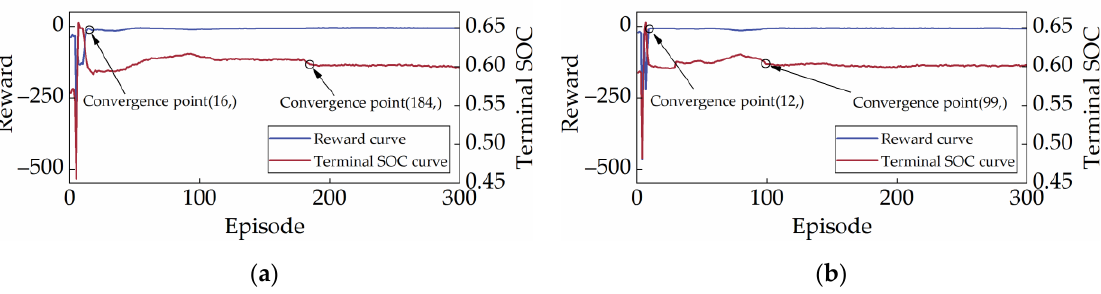
Figure 18. Reward curves and terminal SOC curves under different driving cycles. ( a ) CHTC-B; ( b ) WVUCITY.